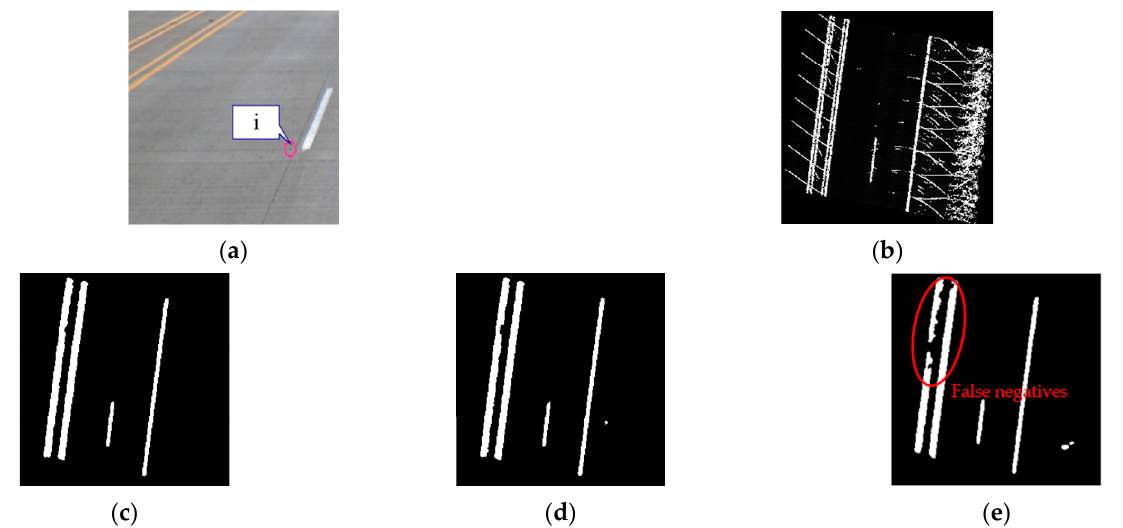
( a ) ( b ) Figure 22. Road delineation of ( a ) NB and SB segments and ( b ) WB and EB segments. Using the corresponding nature of profiles in different dataset segments, the repeat- ability of the proposed strategies for detecting lane markings and generating intensity profiles could be demonstrated. As can be seen in Figure 23a,b, sudden intensity changes in the profiles for both NB and SB segments could be observed at locations I, II, and III within milepost range 6–10. The cause behind these sudden intensity changes was a tran- sition of pavement from asphalt to concrete, shown in Figure 24a,b, where it is known that the average luminance of concrete pavements is 1.77 times that of asphalt pavements [39]. Another area with different asphalt pavements can be seen in Figure 24c. Next, as dis- played in Figure 25, the right-, middle-, and left-edge intensity profiles from the WB seg- ment were almost the same as the left, middle, and right ones, respectively, from the EB segment. At locations IV, V, and VI in Figure 25, the missing lane marking regions could be identified and visualized through the corresponding images, as shown in Figure 26a– c. A roundabout and its merging region led to the long gap for locations IV, V, and VI in Figure 25.